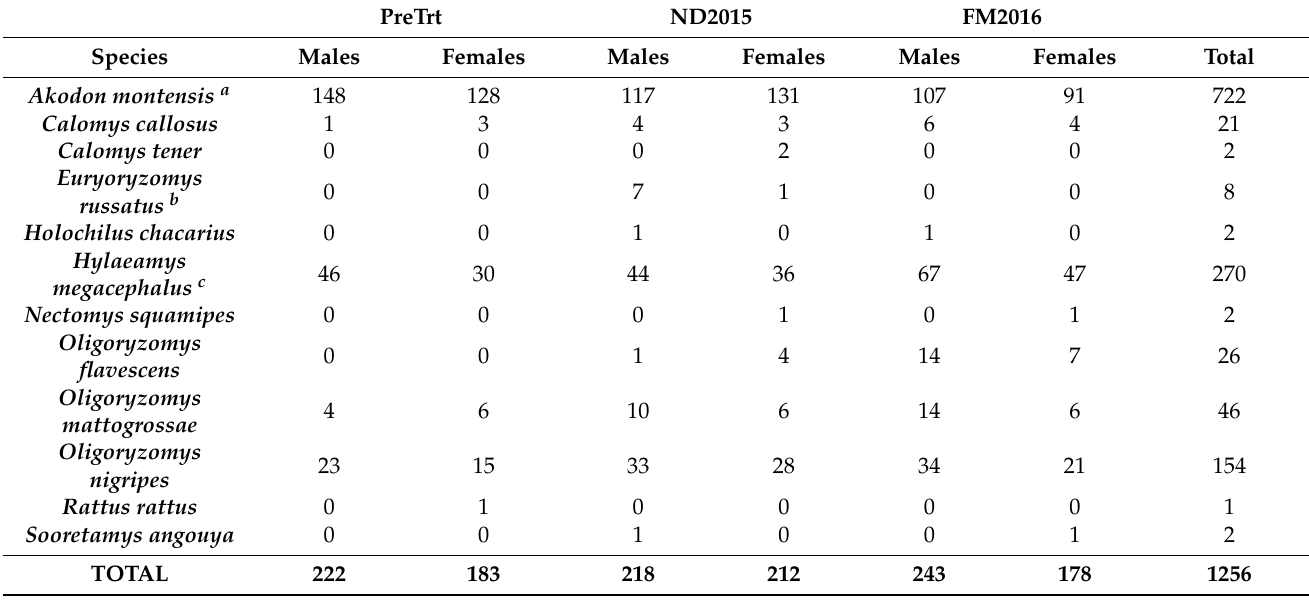
Table 1. Summary of unique male and female rodents by species collected over the course of the study per session. PreTrt ND2015 FM2016 Species Males